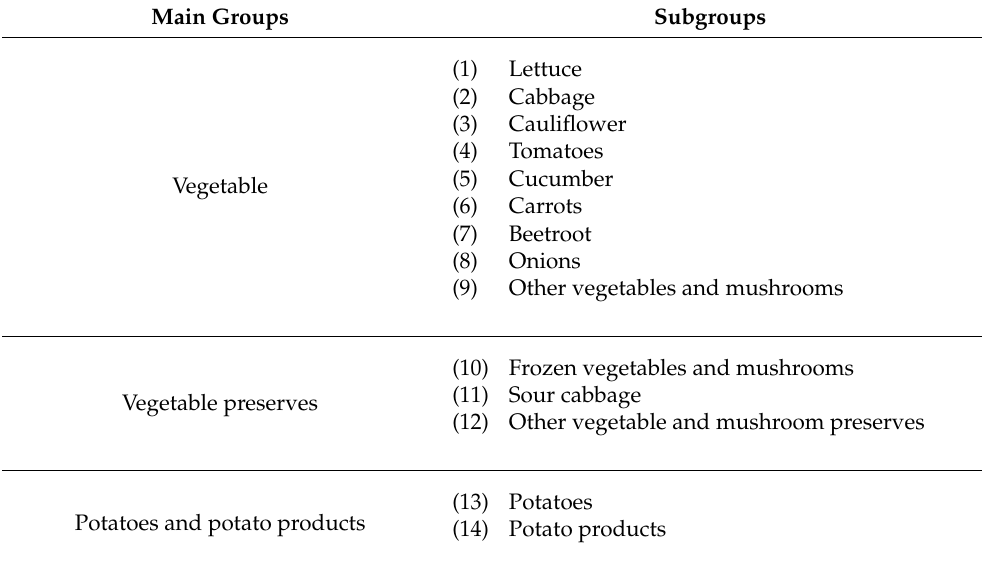
Table 1. Food groups analysed in the